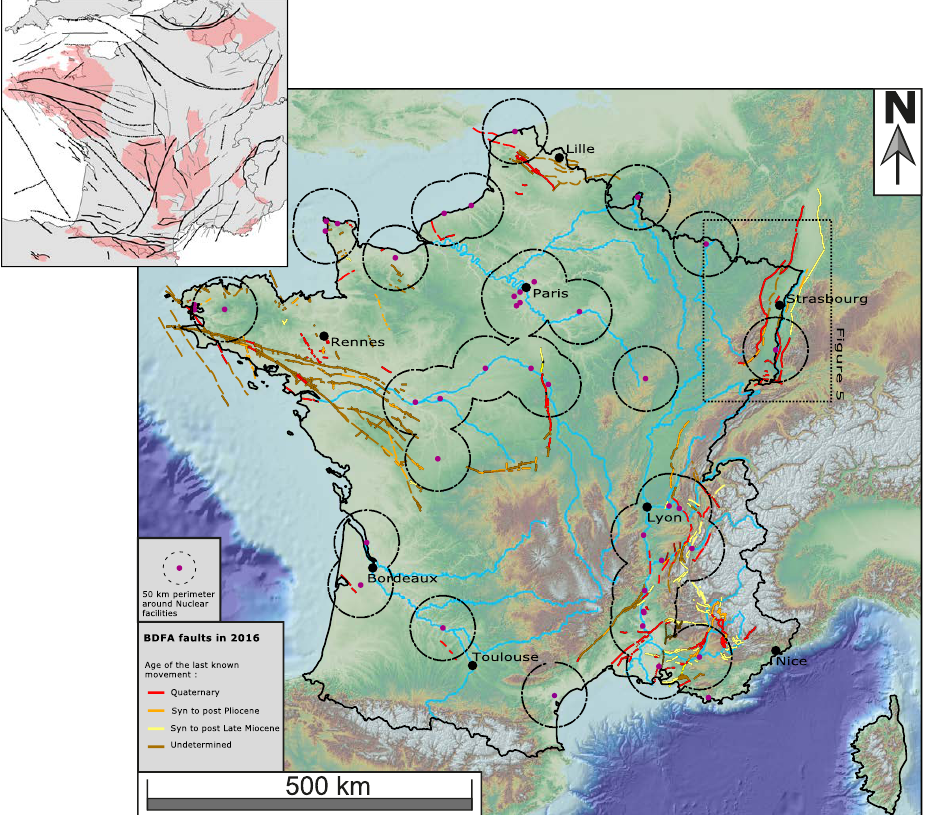
Figure 1. Map of BDFA (Google Earth kml file provided in the Supplement) at the scale of metropolitan France. Faults coloured by the age of the last known movements. Black circles represent a 50km perimeter around each nuclear facility. The black dashed rectangle represents the geographical imprint of Fig. 5. In the top left is a simplified structural sketch of France (modified from Baize et al., 2013): crystalline basement outcrops are defined in light red, major basement faults in black, and minor faults in